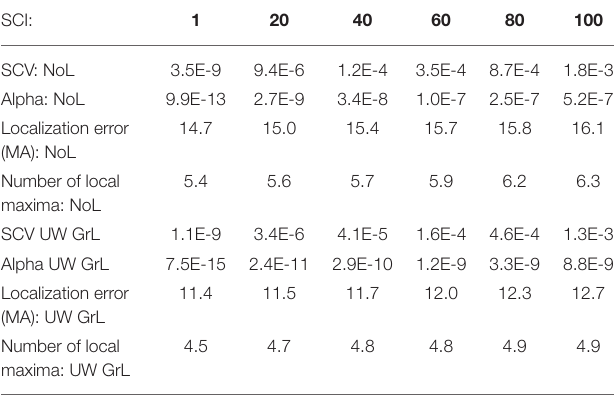
TABLE 3 | Correlation coefficients for the connection between the depth of the simulated sources and the depth of the estimated sources. NoL UW GrL W GrL UW GeL W GeL COM 0.8658